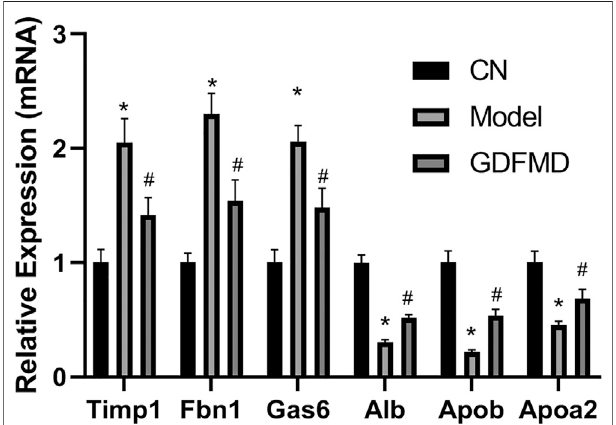
FIGURE 7 | Signi fi cantly enriched KEGG pathways in PPAR signaling pathway. Up-DEGs are marked in red. The pictures were drawn by KEGG Mapper (www.kegg.jp/kegg/tool/map_pathway2.html).